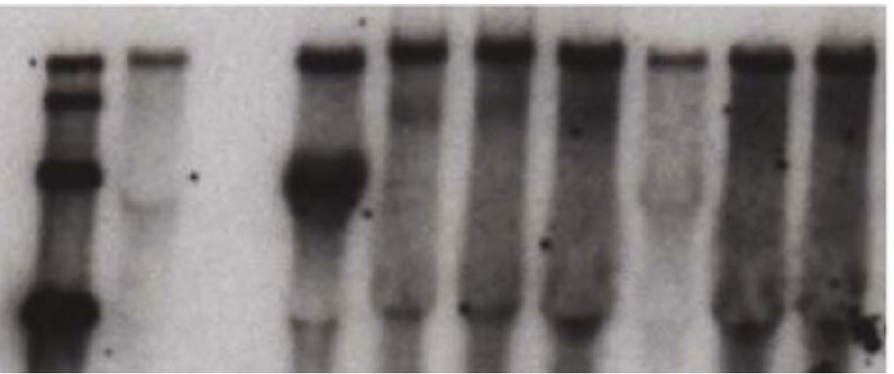
Figure 2. Northern blot analysis of chikungunya virus (CHIKV) intra-genic recombinant isolates. Blot was hybridized with CHIKV-5 9 UTR BioProbe. Lane 1: CHIKV RNA ladder (size markers indicate CHIKV RNAs of full length genomic, replicon, full length structural gene helper, and capsid only structural helper respectively), Lane 2: CHIKV-LR-3 9 D -Replicon only electroporation, Lane 3: CHIKV-LR-5 9 D -Helper only electroporation, Lanes 4 and 8: CHIKV-LR-3 9 D -Replicon/ CHIKV-LR-5 9 D -Helper co-electroporations, and Lanes 5, 6, 7, 9, and 10: clonal recombinant isolates. RNAs of full-length-like size in C6/36 total cellular RNA samples 48 h post infection with putative intra-genic recombinants ( Figure 2; Lanes 5, 6, 7, 9, and 10 ).